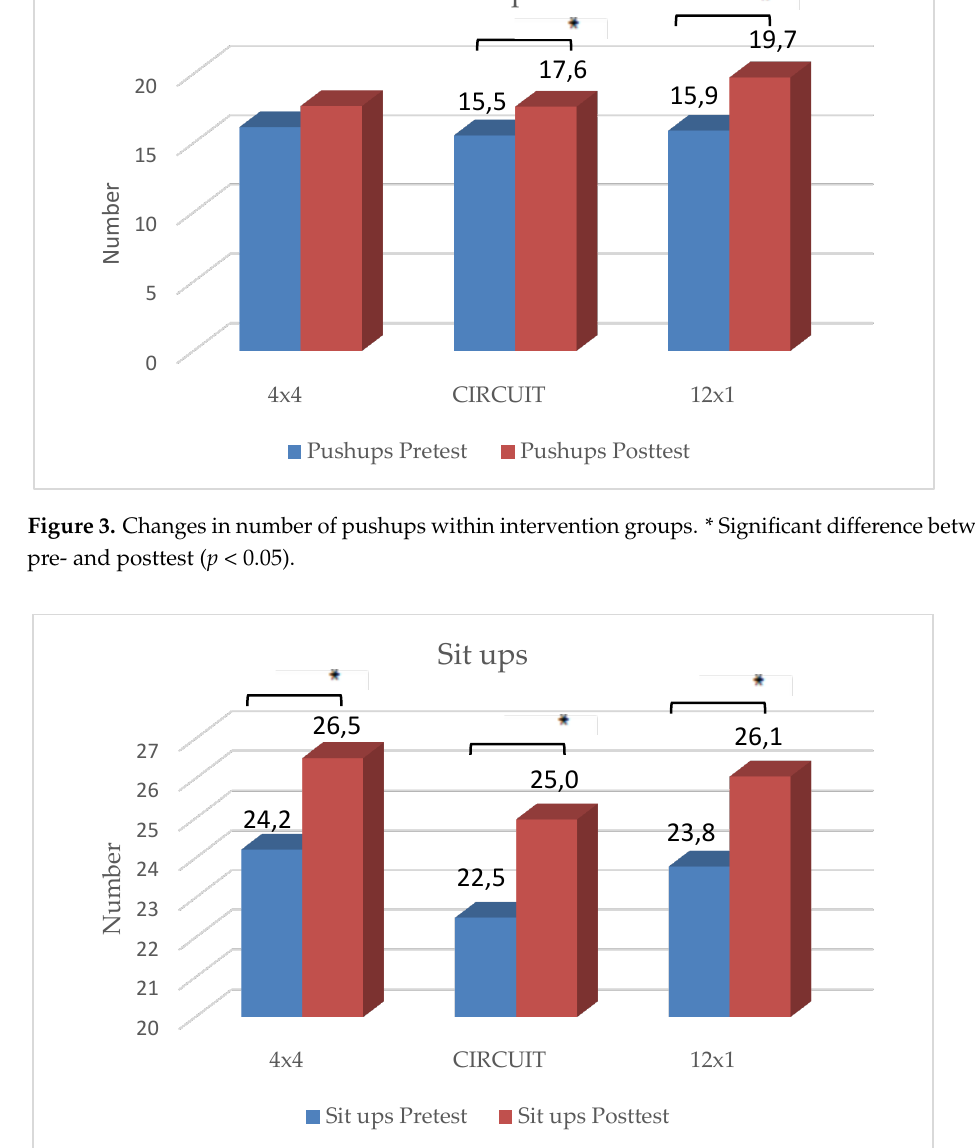
Figure 4. Changes in number of sit-ups within intervention groups. * Significant difference between pre- and posttest ( p < 0.05).